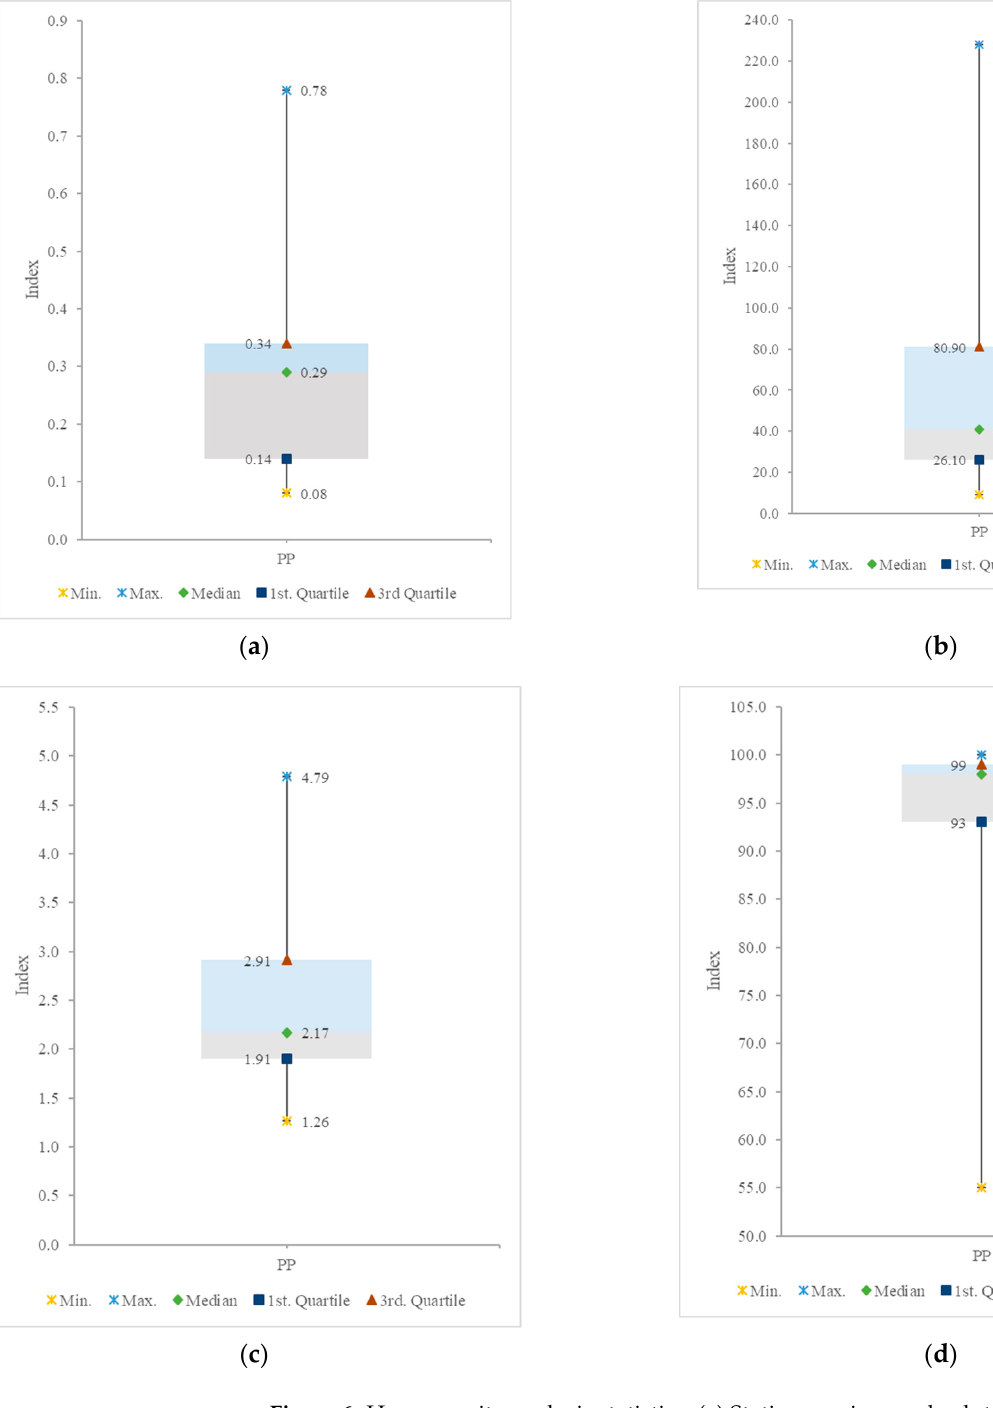
Figure 6. Homogeneity analysis statistics: ( a ) Station maximum absolute autocorrelation (ACmx), ( b ) Standard normal homogeneity test (SNHT), ( c ) Root mean squared error (RMSE) and ( d ) Percentage of original data (POD). Table 2. Homogeneity analysis statistics for each station.